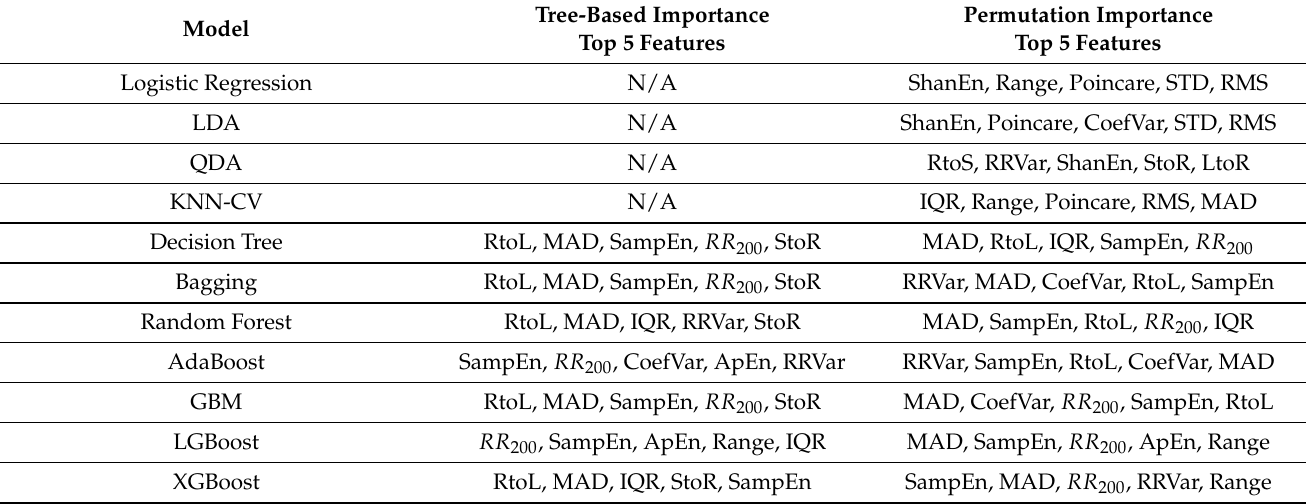
Table 8. Top five features for all models with the 25-s segmentation